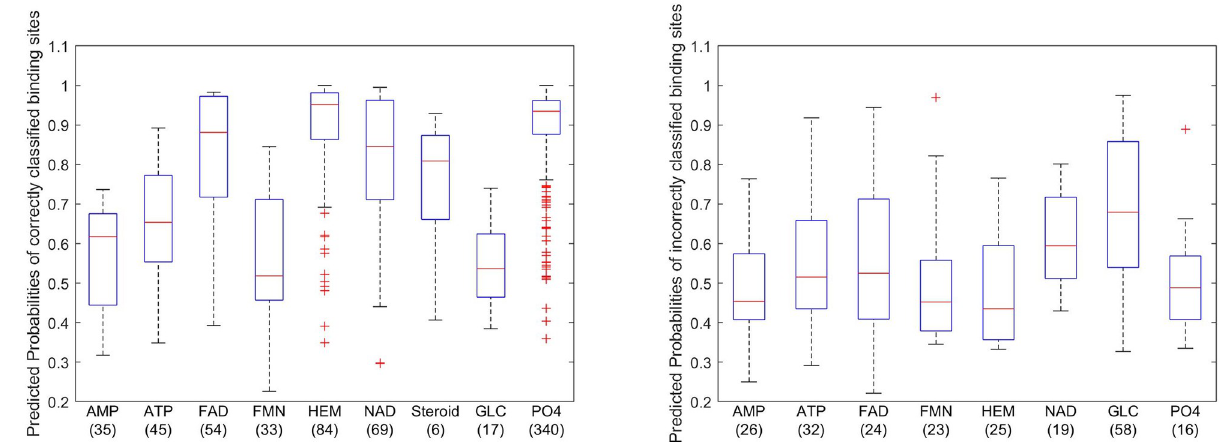
Fig 8. Distributions of predicted probabilities of binding sites by ligand group. (Left) correctly classified binding sites of each ligand groups. (Right) incorrectly classified binding sites of each ligand groups.